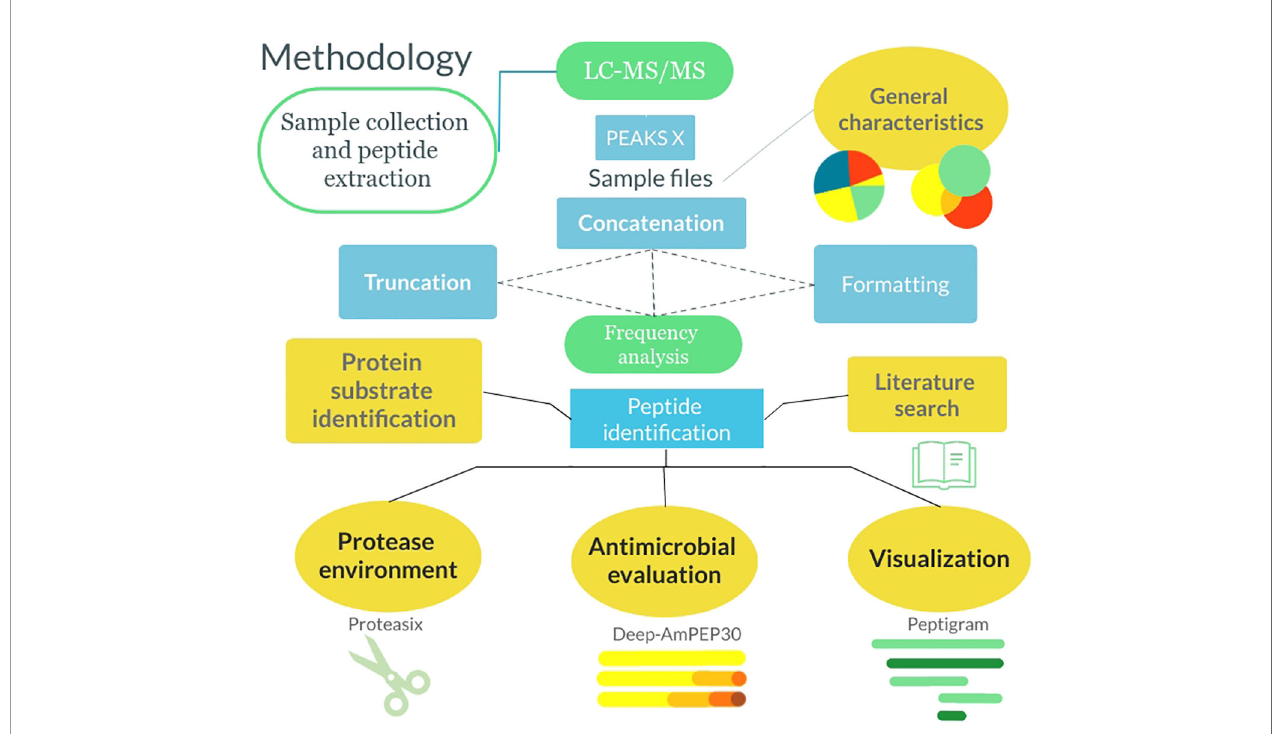
FIGURE 1 | Flowchart describing the methodology from sample collection to data analysis. The samples were collected, and the peptides were extracted. Following this, the samples were analyzed by LC-MS/MS and run through PEAKS X. Thereafter the general characteristics of the peptidomes were extracted and the fi les were formatted and sorted in Python. Lastly, analysis was done using algorithms in Python as well as utilizing 3 rd party